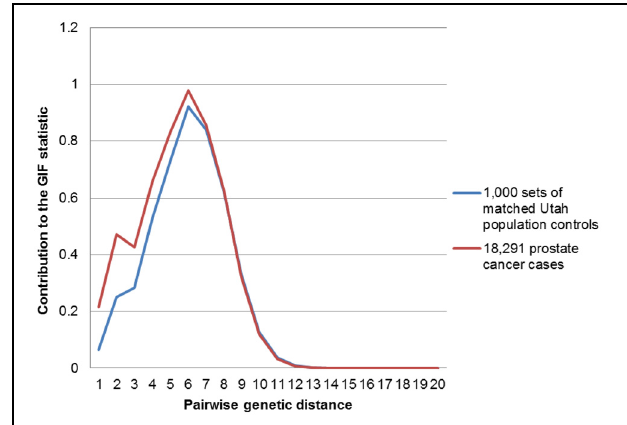
FIGURE 3 | Contribution to the GIF statistic by pairwise genetic distance for cases and controls for prostate cancer cases diagnosed before age